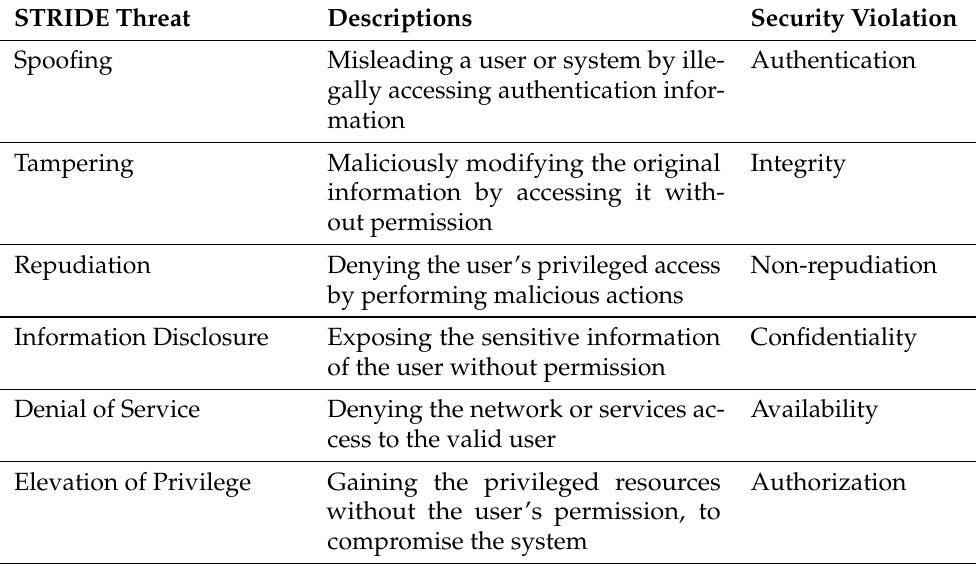
Table 3. STRIDE Mapping with Security